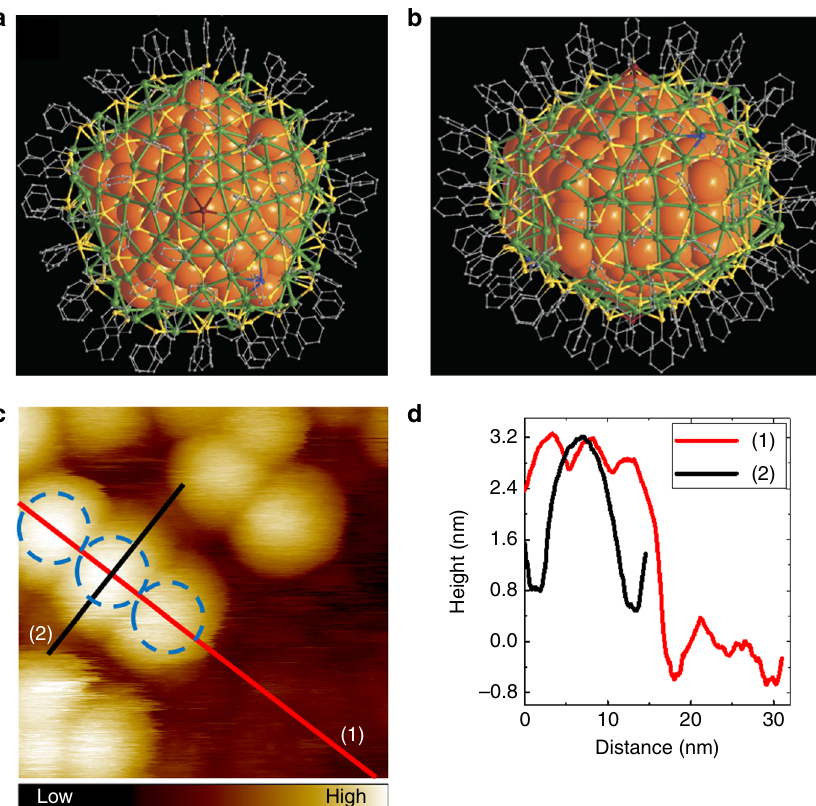
Fig. 1 Total structure of Ag 374 nanoparticle and its appearance in STM imaging. a , b Complete cluster structure shown in a plane perpendicular to a fi ve- fold rotation axis and a plane parallel to the fi ve-fold axis, respectively (from ref. 21 , copyright 2016 SpringerNature). c STM topography image of Ag 374 at LHe temperature. Scan size: 25.1 × 25.1 nm 2 , bias and setpoint current: 1.2 V and 30 pA. Blue dashed circles indicate nanoclusters with a de fi ned size (diameter 5 nm) and their locations. d Height pro fi les taken along the red and black lines in